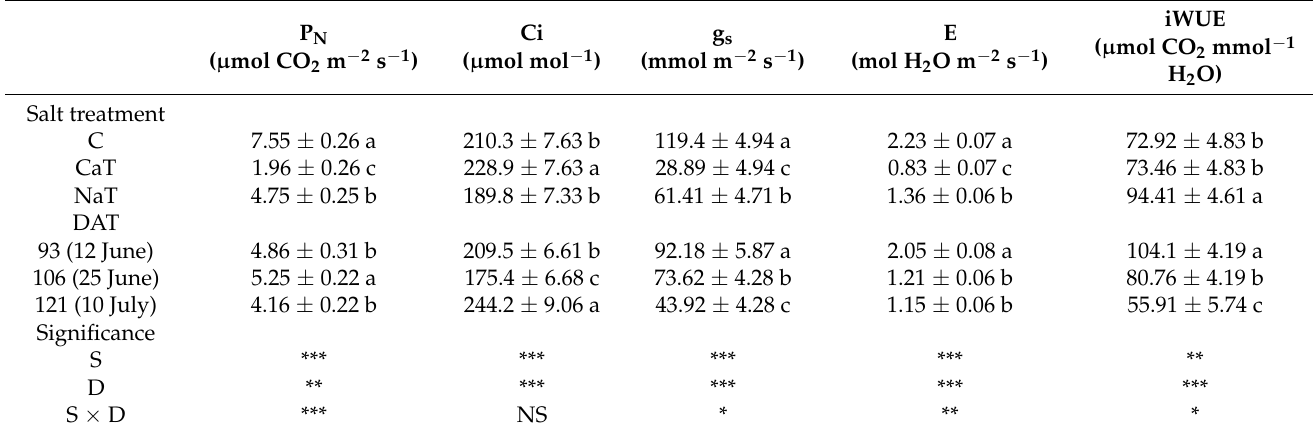
Table 2. Effects of salt treatment in the nutrient solution on net-photosynthetic rate (P N ), sub-stomatal CO 2 concentration (Ci), stomatal conductance (g s ), transpiration rate (E), and intrinsic water use efficiency (iWUE) in C. citrinus plants. Mean values and standard errors are shown. Different letters correspond to significantly different values ( p < 0.05).